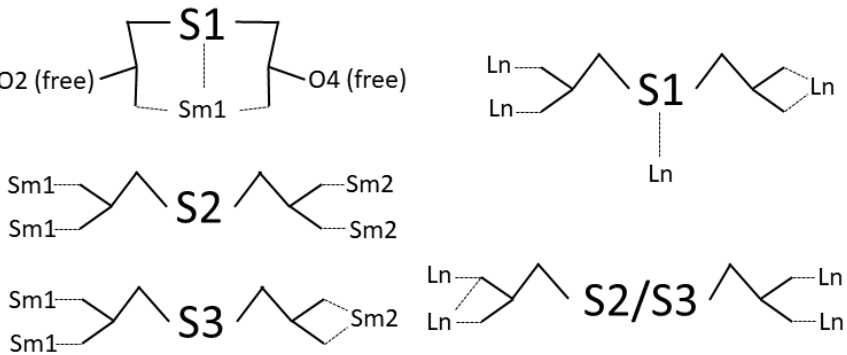
Scheme 1. Coordination modes of tda in compound 1 ( left ) and in previously reported structures [Ln 2 (tda) 3 (H 2 O) 2 ] ( right )